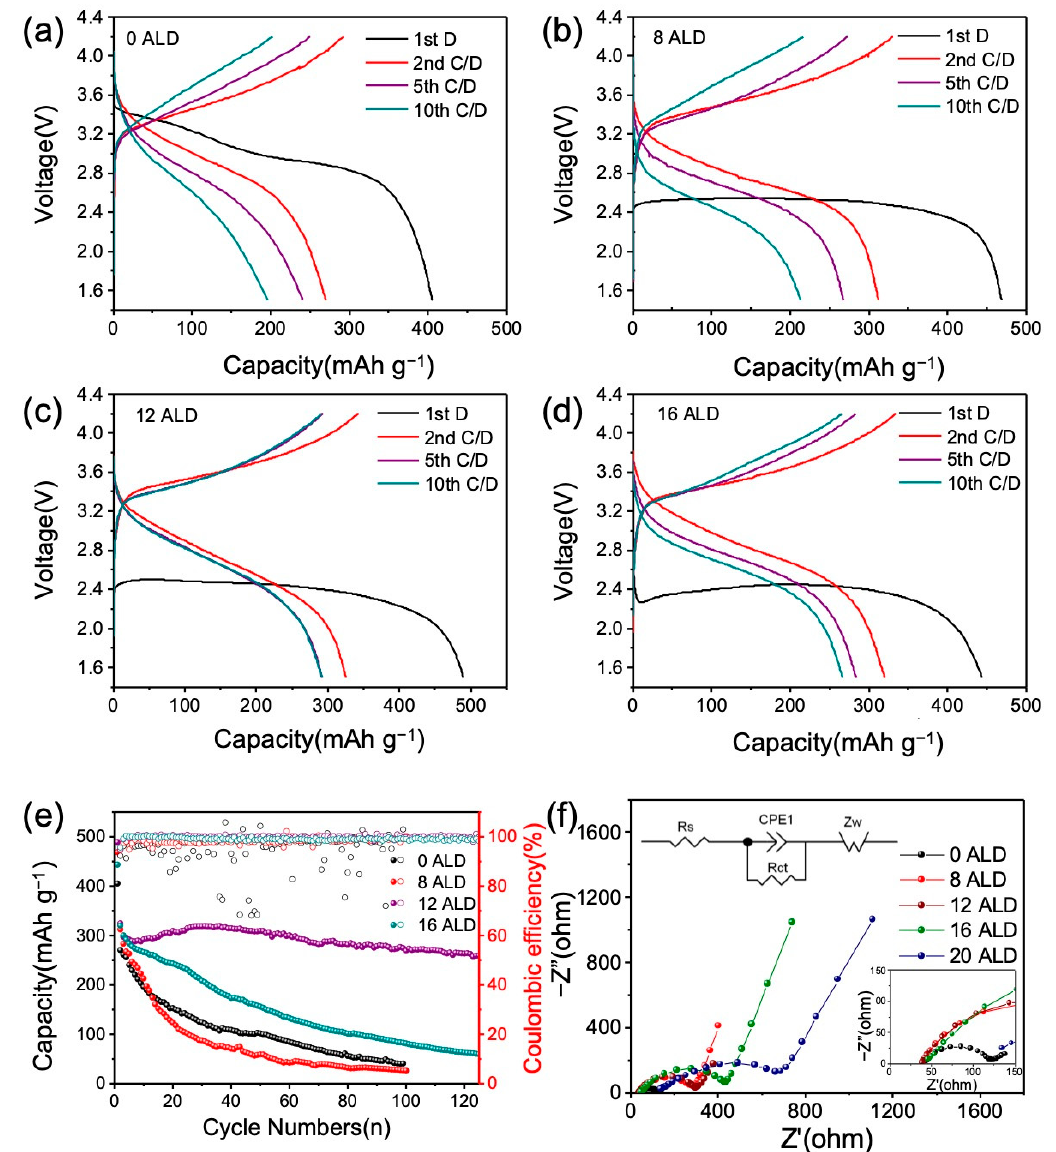
Figure 4. Charge/discharge curves of Cr 8 O 21 all-solid-state cells with different ALD cycles at 60 ◦ C: ( a ) without Al 2 O 3 coating, ( b ) 8 ALD cycles, ( c ) 12 ALD cycles, ( d ) 16 ALD cycles; ( e ) Cycling performance (the left vertical axis) and CE (the right vertical axis) of the Cr 8 O 21 all-solid-state cell with different ALD cycles (0, 8, 12, 16). ( f ) EIS profiles of the Cr 8 O 21 all-solid-state cell with different ALD cycles (0, 8, 12, 16, 20) at 60 ◦ C and the equivalent circuit model of EIS